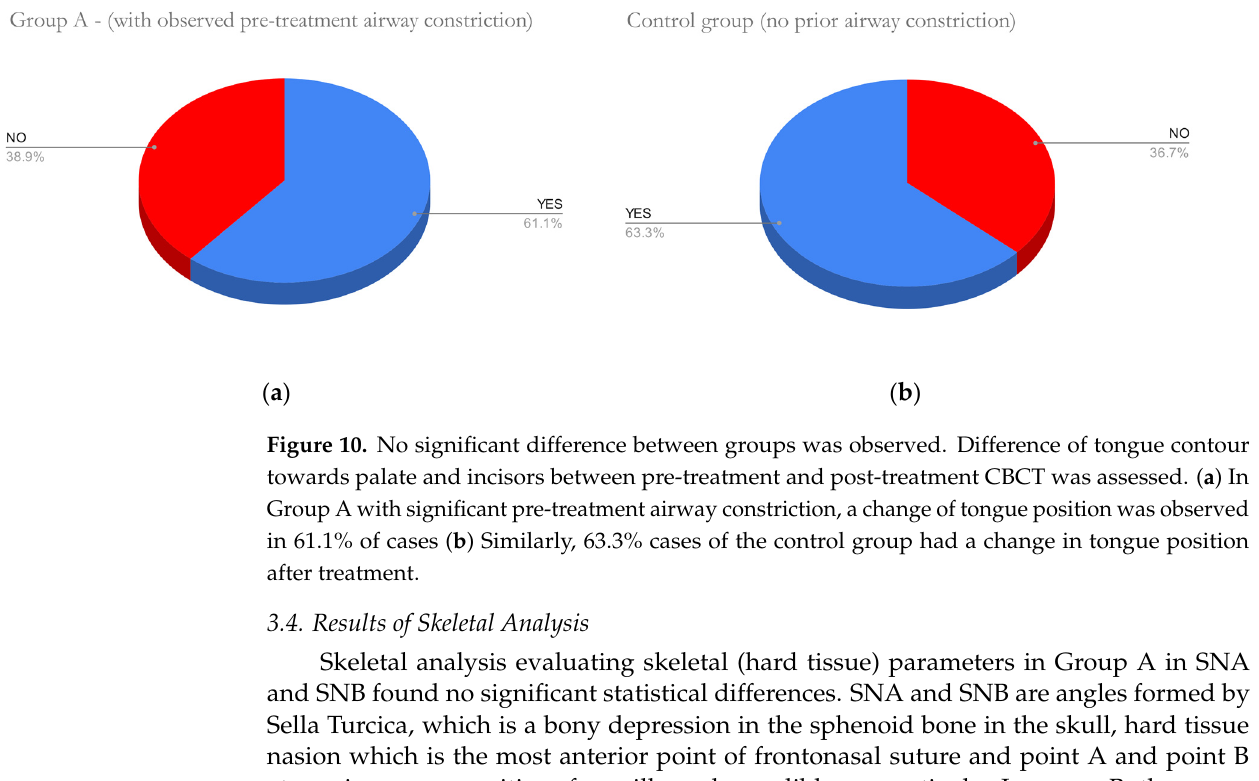
in a changed position of the tongue in 61.1% cases, and similarly 63.3% in the control group (Figure 10).